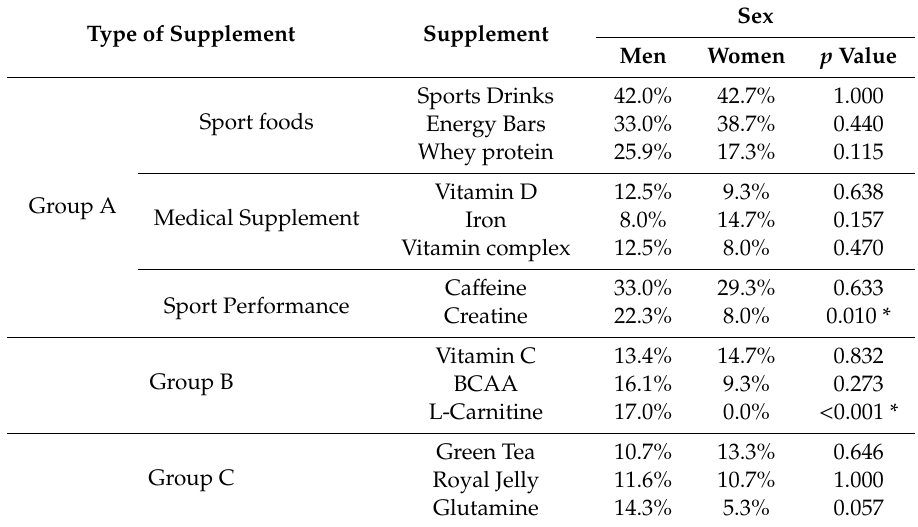
Table 3. Most-commonly used supplements according to sex in a sample of handball players.